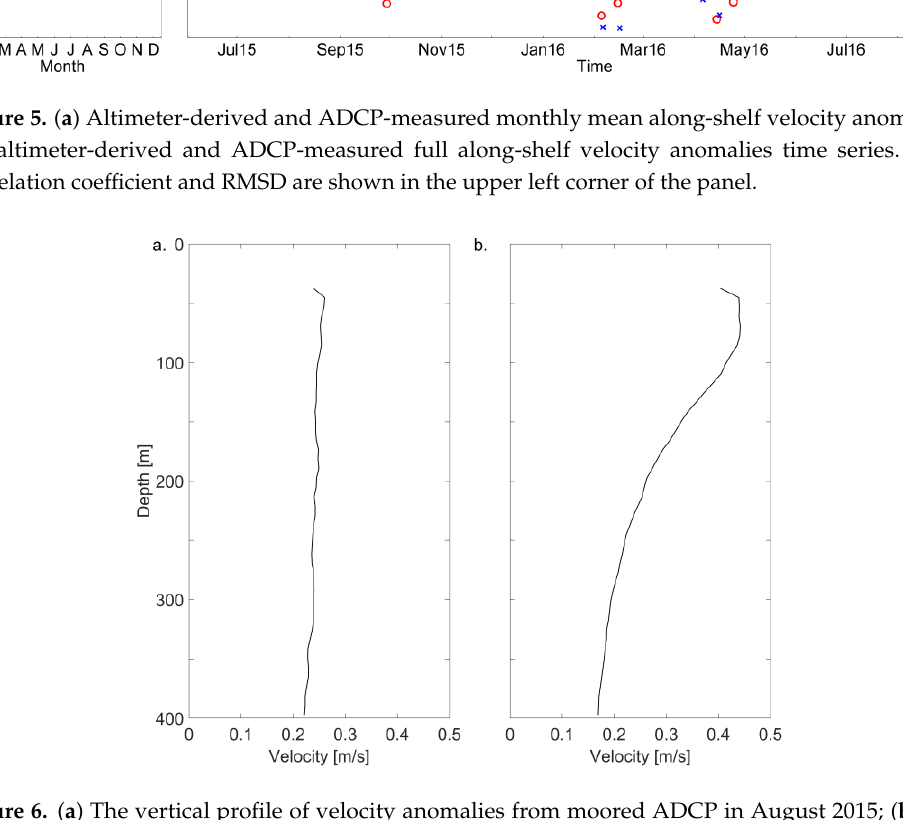
Figure 6. ( a ) The vertical profile of velocity anomalies from moored ADCP in August 2015; ( b ) the vertical profile of velocity anomalies from moored ADCP in February 2016. vertical profile of velocity anomalies from moored ADCP in February